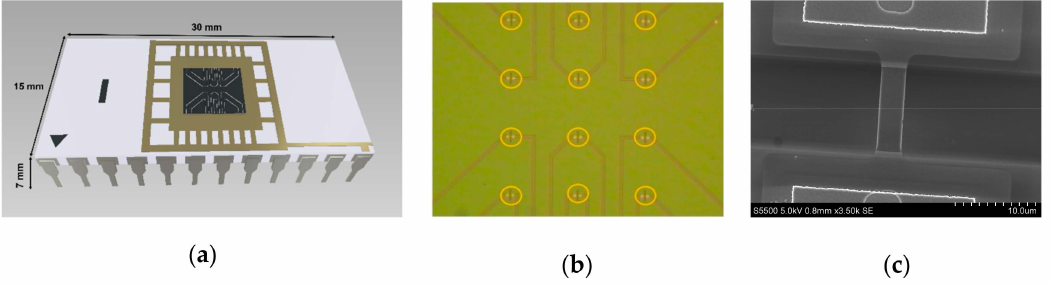
Figure 3. ( a ) The model of the SOI-NW chip being used. ( b ) An optical image of the surface of the SOI-NW chip. The arrangement of nanowires on the chip surface is outlined with orange color. ( c ) A SEM image of an individual silicon